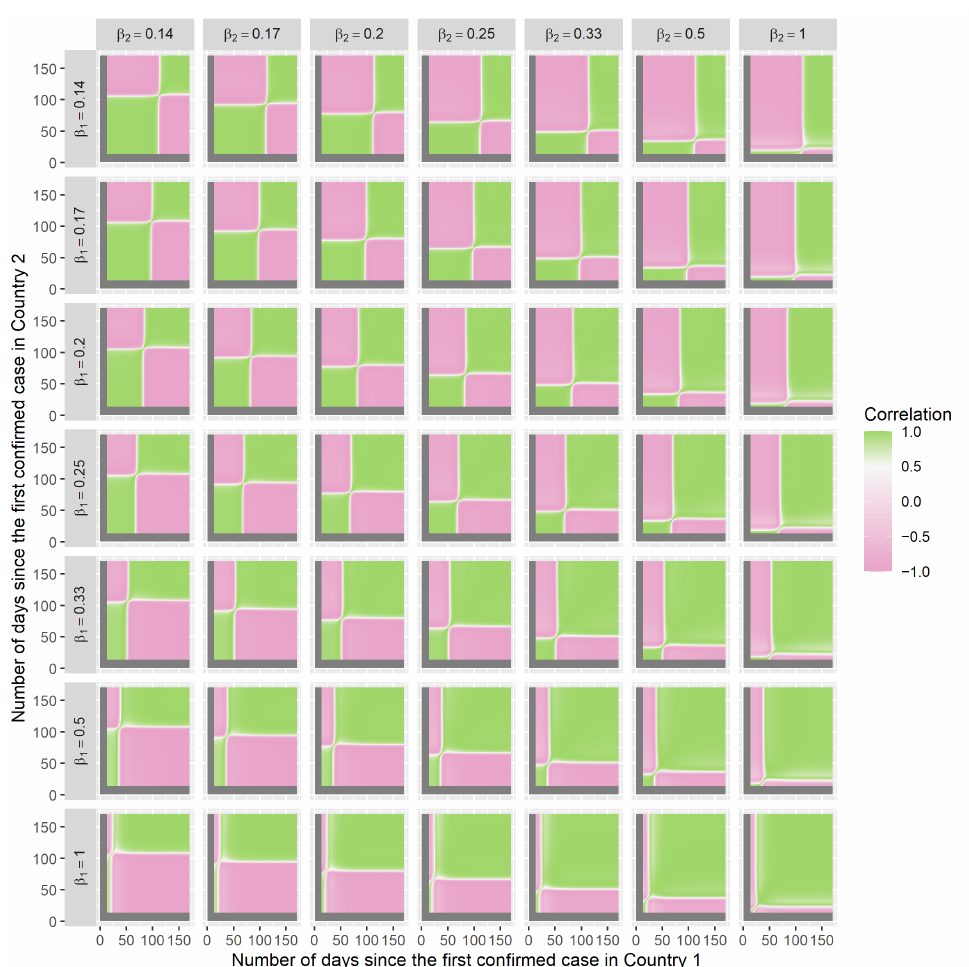
Figure A1. The x -axis and y -axis in each plot refer to the number of days since the first confirmed case in each of the two countries, respectively. The region in green represents the scenarios when the correlation between the two countries is greater than